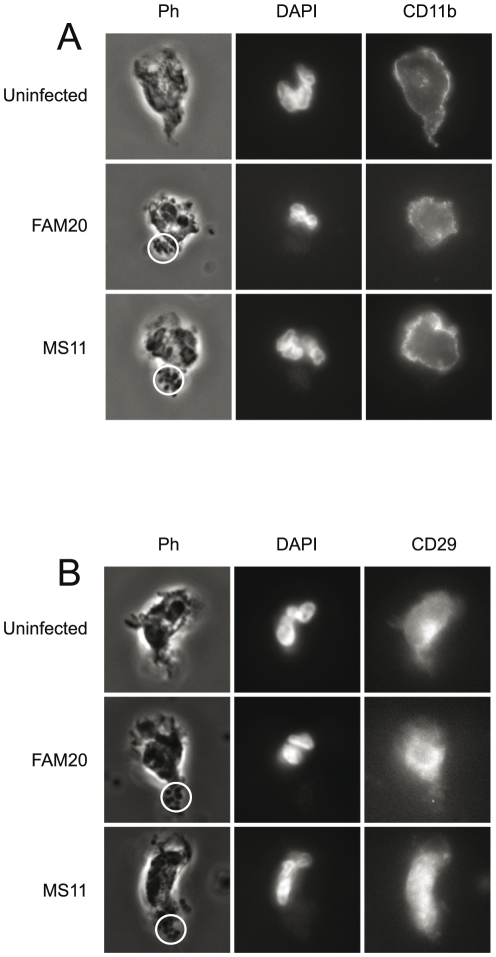
CD11b and CD29 expression in infected and uninfected PMNs.
N. gonorrhoeae MS11 and N. meningitidis FAM20 bacteria were allowed to adhere to freshly isolated PMNs. Cells were fixed, permeabilized and incubated with monoclonal antibodies against CD11b or CD29 and cellular DNA was stained with DAPI. Phase contrast images show the PMN morphology and bacterial adherence. Circles indicate bacteria. (A) Representative images of CD11b expression in PMNs infected with wild-type and mutant gonococci and meningococci. (B) Representative images of CD29 expression in PMNs infected with wild-type and mutant gonococci and meningococci.